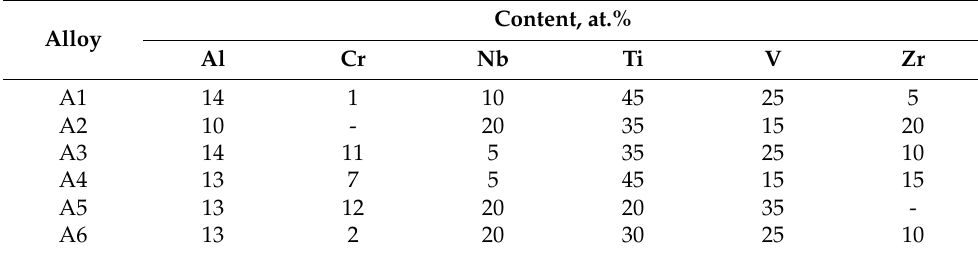
Table 2. Chemical compositions of the model